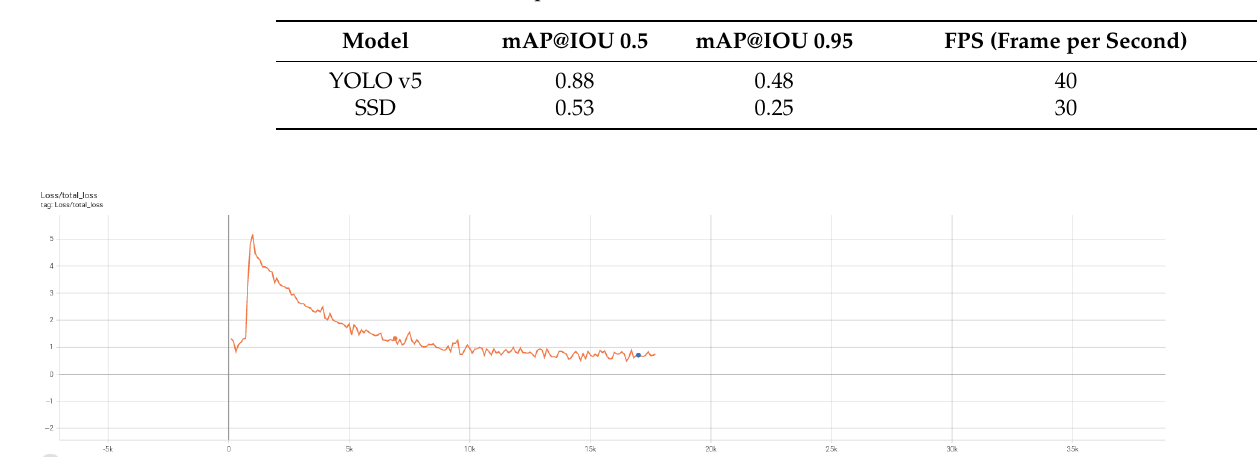
Table 2. Performance comparison of YOLOv5 and SSD-ResNet.